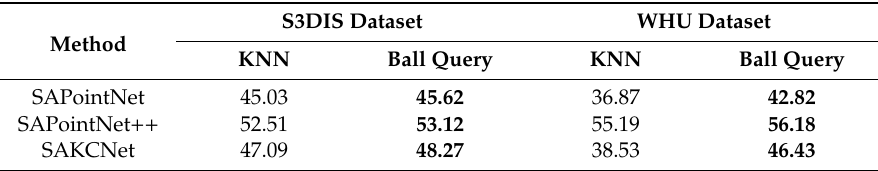
Table 6. Mean IoUs (%) of semantic segmentation results with di ff erent local neighborhood searching methods.